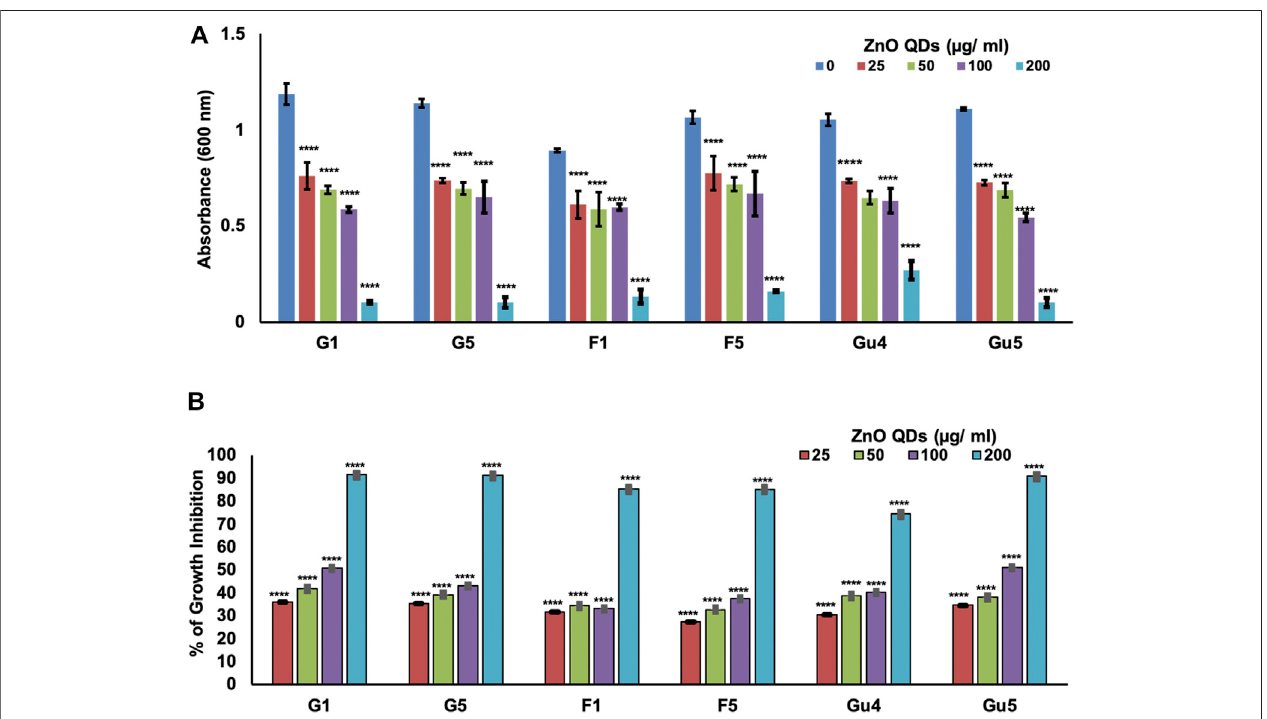
FIGURE 3 | Determination of dose-dependent antimicrobial activity of ZnO QDs against C. albicans strains (isogenic matched pairs G1 and G5, F1 and F5, and GU4 and GU5): (A) Determination of growth by measurement of OD 600nm using the broth microdilution method for C. albicans cells grown at 30 ° C in the presence of 0, 25, 50, 100, and 200 µg/ml of ZnO QDs, respectively. The values given are mean ± SD of three independent sets of experiments. **** represents p < 0.0001, calculated withrespecttogrowthcontrol(absenceofZnOQDs); (B) Percentageofgrowthinhibitionof C.albicans strains(isogenicmatchedpairs)inthepresenceofZnOQDs (0,25,50,100,and200 µg/ml).Thevaluesgivenaremean ± SDofthreeindependentsetsofexperiments.****represents p < 0.0001,calculatedwithrespecttogrowth control (absence of ZnO QDs).